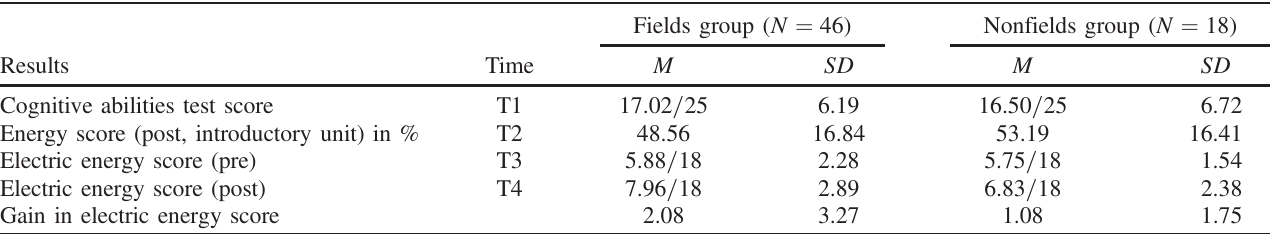
TABLE II. Results of both groups in the tests on electric energy, energy from the introductory unit, and cognitive abilities.